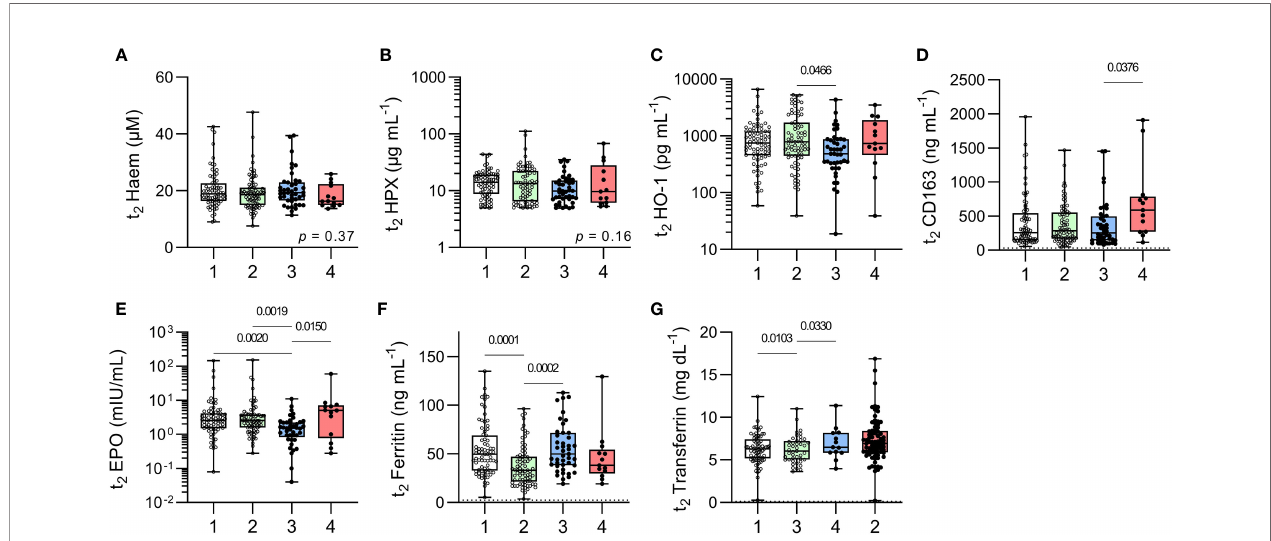
FIGURE 4 | Markers of erythropoiesis in uninfected children and children with resolved or persistent P. falciparum infections. Concentrations of soluble proteins in plasma for (A) Haem, (B) Haemopexin (HPX), (C) haemoxygenase-1 (HO-1), (D) soluble CD163, (E) erythropoietin (EPO), (F) Ferritin (iron load), and (G) Transferrin (ferric-ion delivery). Data shown as box plots with min/max whiskers where dots represent each participant. Signi fi cant p values shown, calculated using a Kruskal- Wallis rank sum test followed by a post-hoc Dunn ’ s test with Bonferroni adjustment for multiple comparisons. Group IDs: #1 ‘ Controls ’ , #2 ‘ Anaemic ’ , #3 ‘ Resolved ’ , and #4 ‘ Chronic ’ .